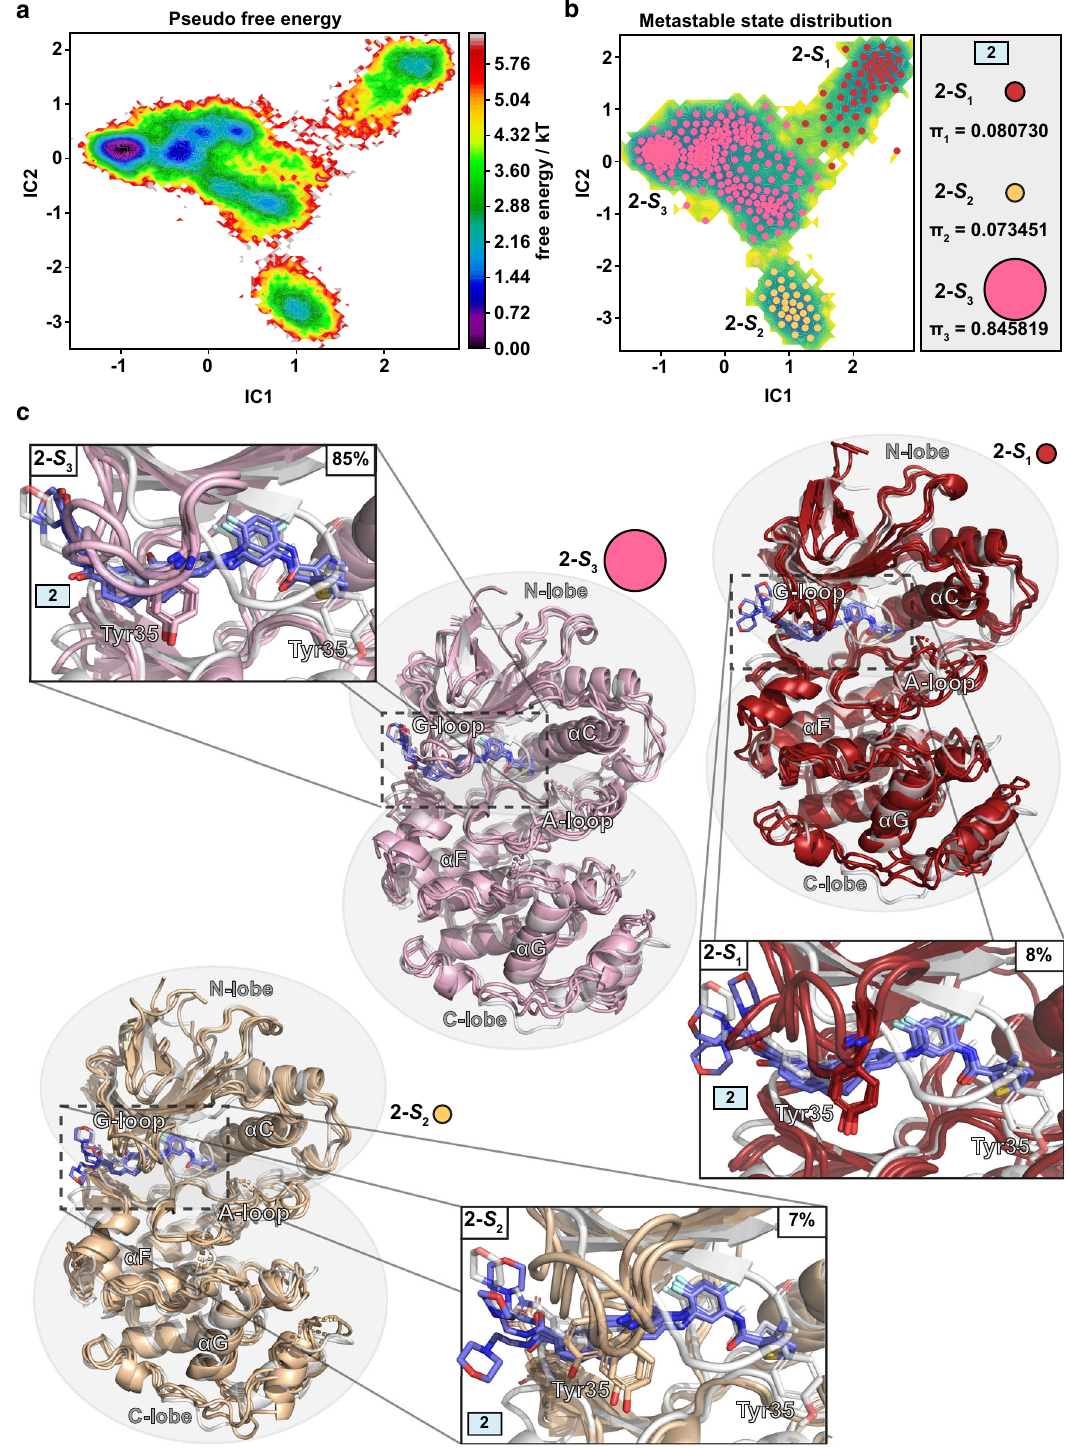
Fig. 3 MSM metastable states of p38 α MAPK-2 complex. a Pseudo-free energy map of distributions along time-lagged independent components (ICs) 1 and 2. b Separation of the three metastable states ( 2- S 1 – 2- S 3 ) by PCCA ++ analysis. Equilibrium probability ( π i ) for each state is indicated together with circles, which exhibit an area that is relative to their state probability. c Representative conformations of the metastable states. Each metastable state ( 2-S i ) is illustrated with three representative structures (colored cartoons: 2- S 1 , red; 2- S 2 , wheat; 2- S 3 , pink) and the simulation starting conformation is shown as a reference in